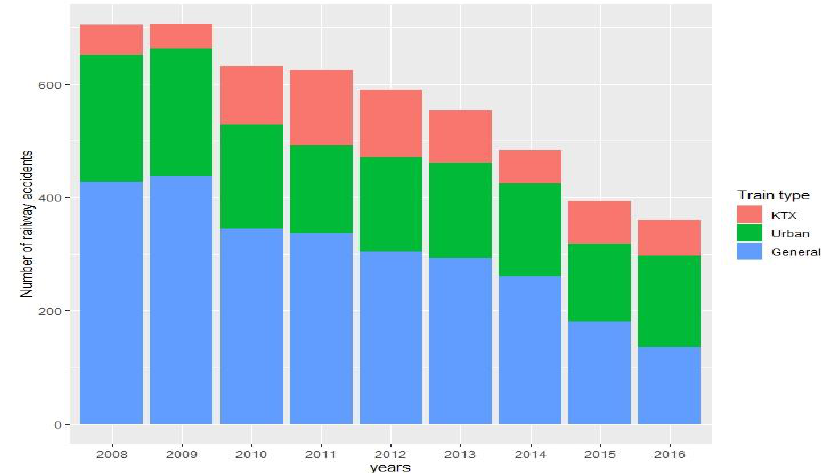
Figure 1. Time series plot of the number of railway accidents (2008 – 2016).